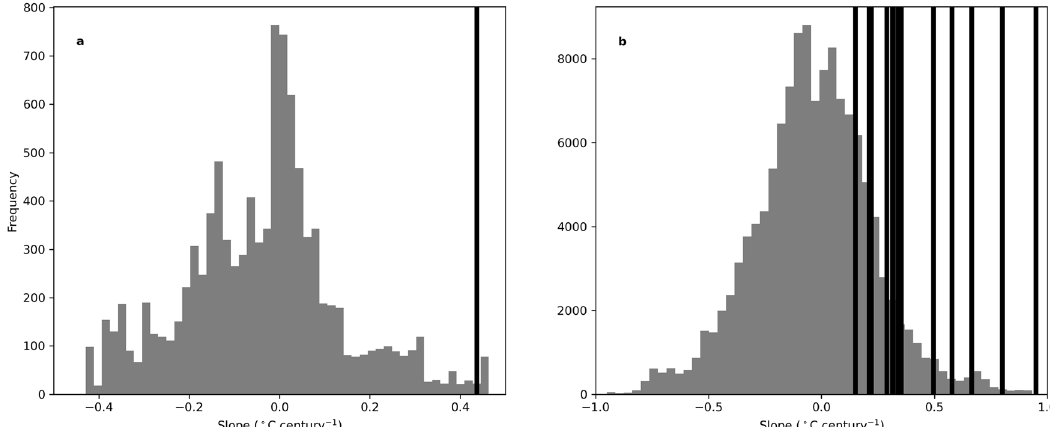
Fig. 6 Linear regression analysis of temperature trends in the Gulf of Maine. Histograms show the distribution of slopes of linear regression analysis of 100-year periods in the 1000 year Gulf of Maine temperature simulation of the fully forced ensemble member mean ( a ) and individual ensemble members ( b ). The ensemble member mean and each of the individual ensembles was sampled 10,000 times using Monte Carlo simulations. Black vertical lines show the slope of the linear regression of the most recent 100 years of the Gulf of Maine temperature simulations for the ensemble member mean ( a ) and the individual ensemble members ( b